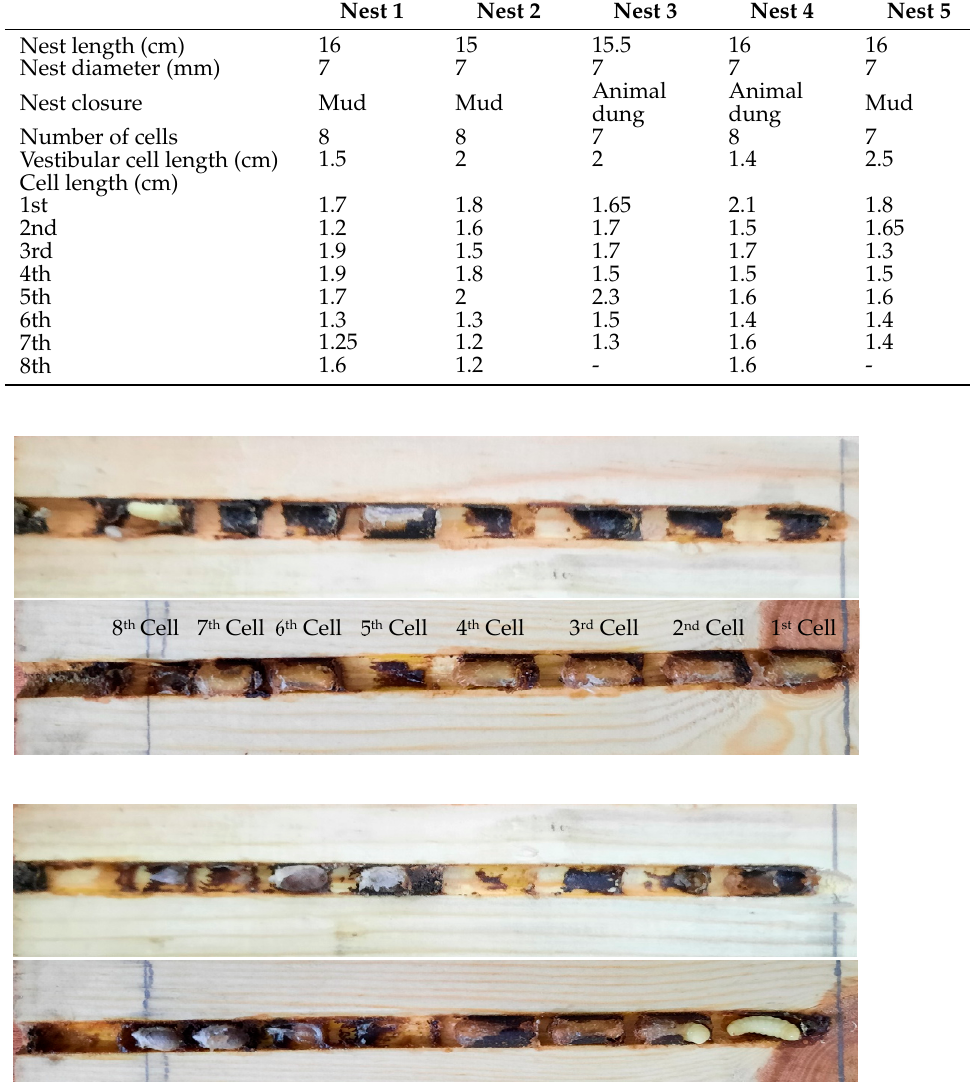
Table 1. Nest measurements of Megachile cephalotes -occupied nests.